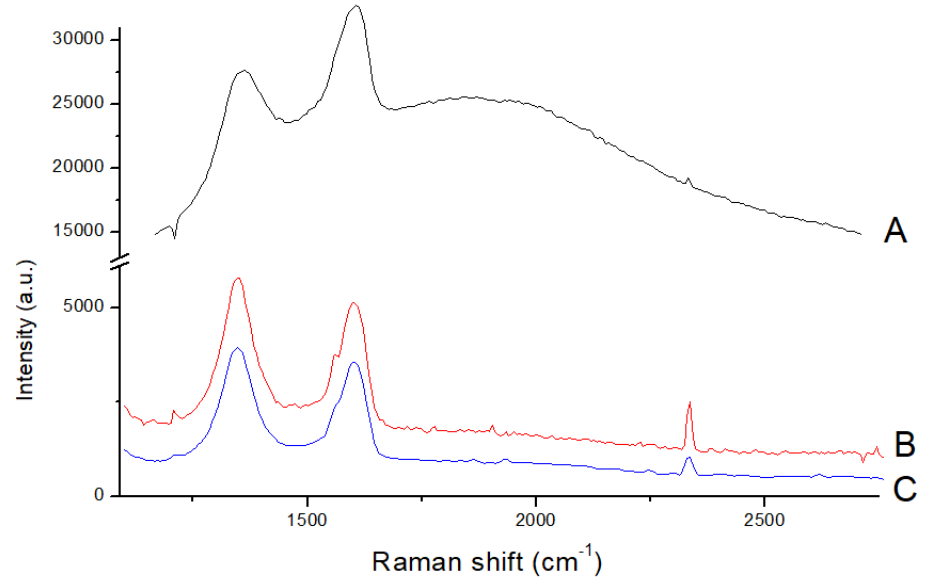
Figure 3. Raman spectra of GO ( A ), erGO ( B ), and CD1 − erGO ( C